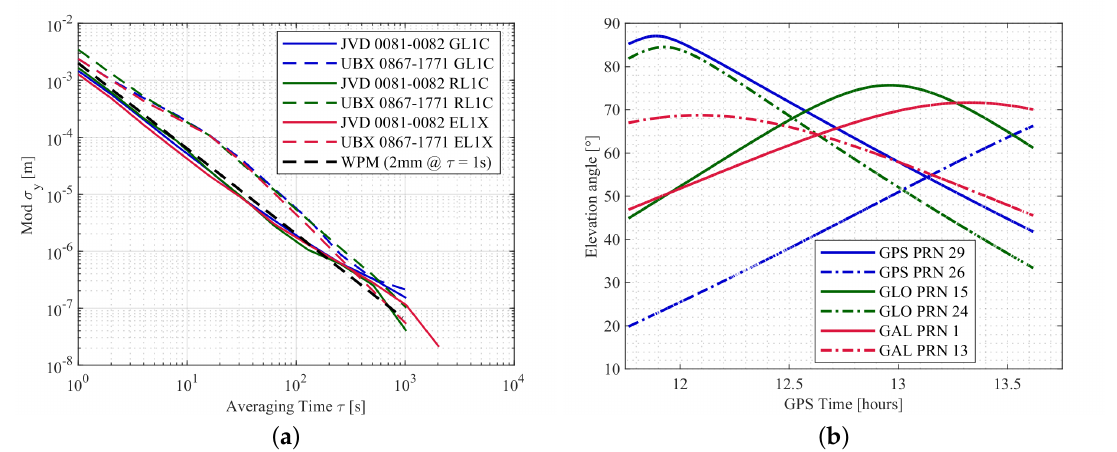
Figure 9. Modified Allan deviations of the L1 carrier phase DDs for one satellite pair of each GNSS system with two different receiver combinations in ( a ). For GL1C, RL1C and EL1X, DDs of PRN 29–26, PRN 15–24 and PRN 1–13 are used, respectively. The elevation angles of these satellites are shown in ( b